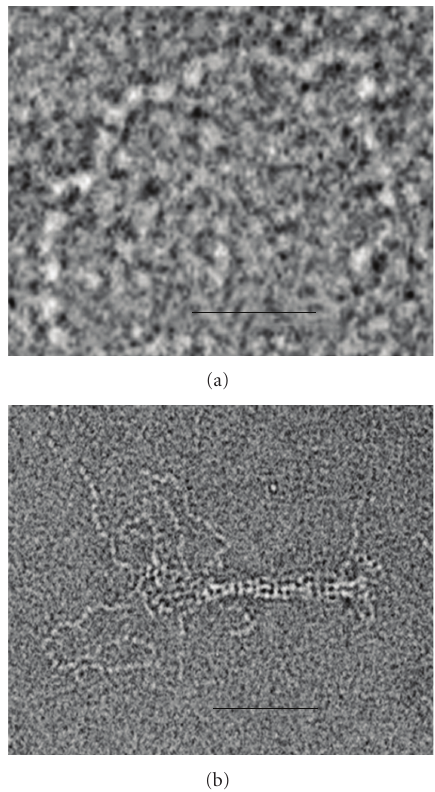
Figure 2: Electron micrographs of negatively stained titin, illus- trating domain substructure and flexibility (a), and the e ff ect of bundling on the apparent sti ff ness of the molecule (b). (a) Note that each of the flexibility “waves” seen in the titin contour contains about 4 domains. This number is comparable with the number of domains (3-4) expected for segments of about the persistence length of the protein. (b) This micrograph shows partially dissolved titin “end-filament”. The “wavy” contours of the molecules in the unbundled region contrast with their relatively straight shapes in the bundled part. Magnification: bar (a) 20 nm; (b) 50